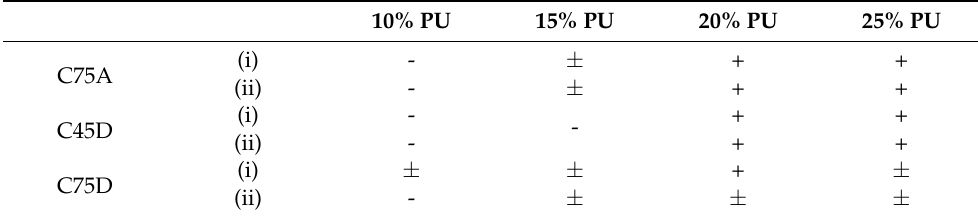
Table 2. Symbolic description of prostheses obtained for various concentrations of PU ( n =